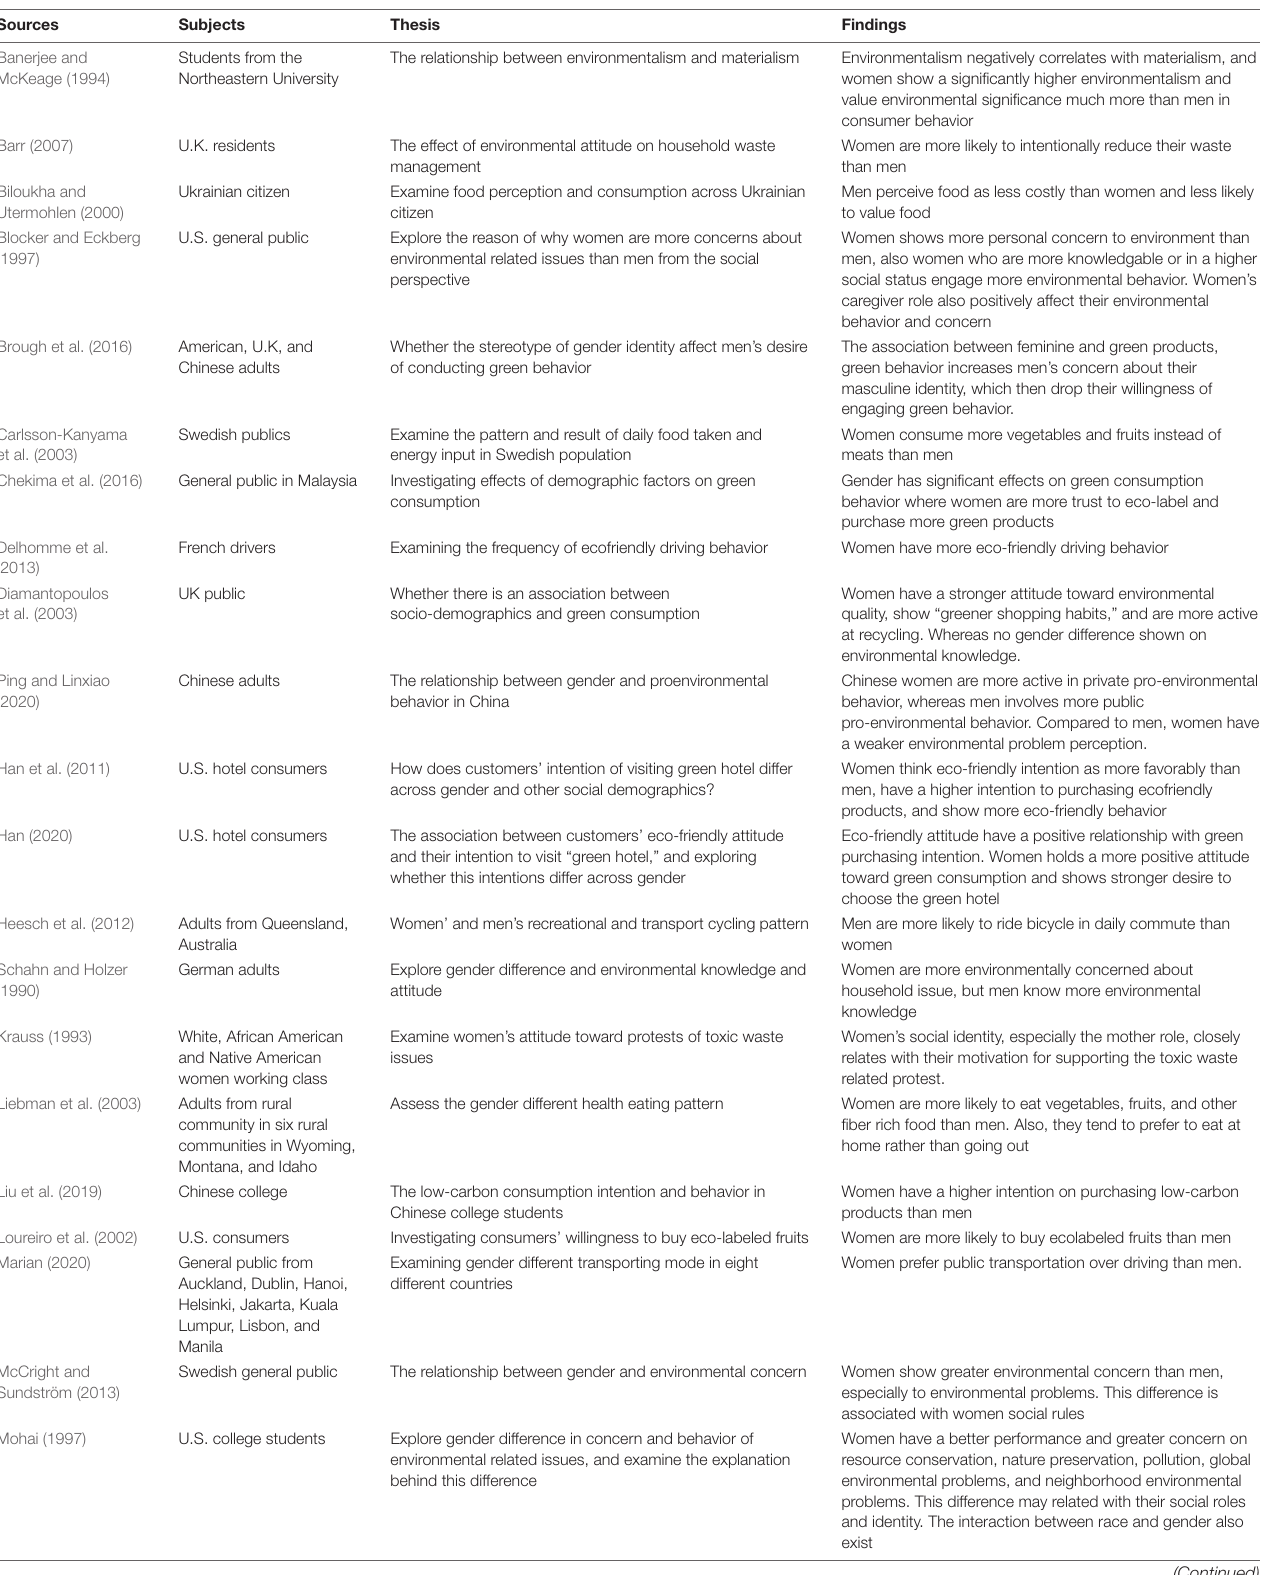
TABLE 1 | Comparison of gender differences in green consumption behavior and